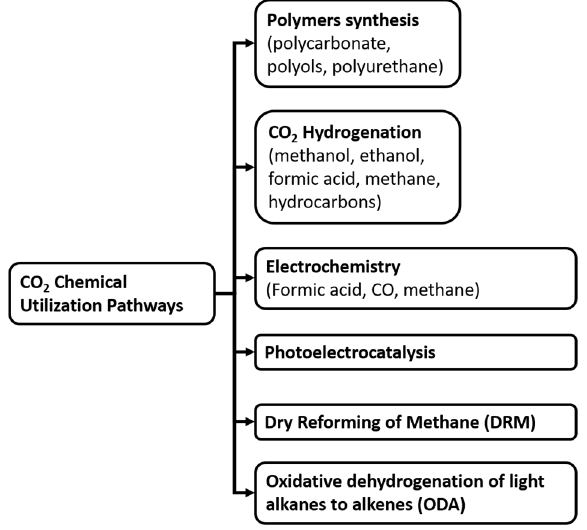
Figure 22. Main CO 2 transformation processes and resulting products. Adapted from: [156].